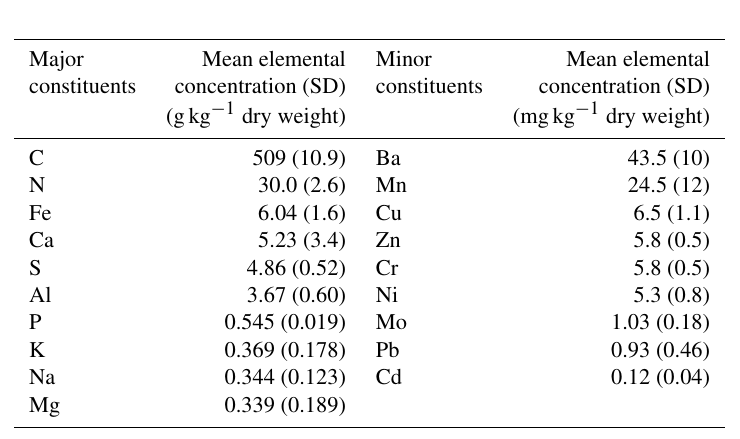
Table 1. Chemical properties of permafrost soil samples from the palsa surface at SAS1. Each value is the mean (standard deviation) of triplicates.